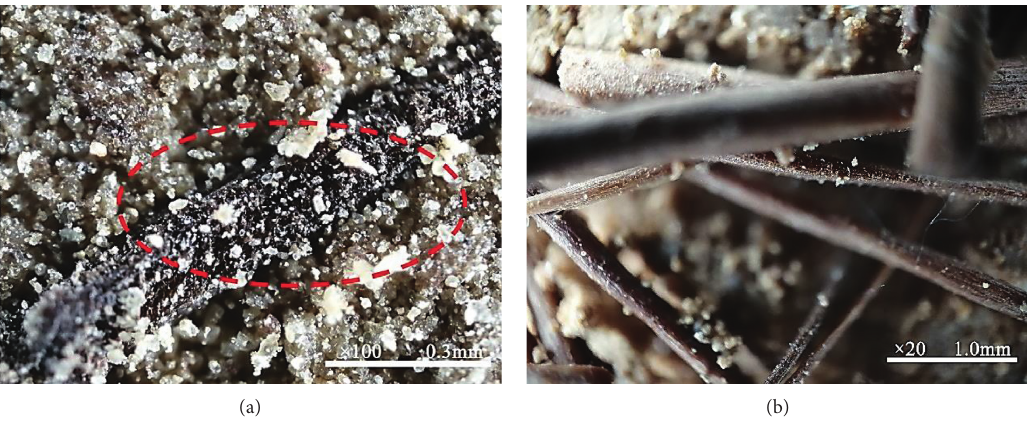
Figure 7: Distribution and surface characteristics of fibers in palm fiber-reinforced soil. (a) Single and (b) multiple